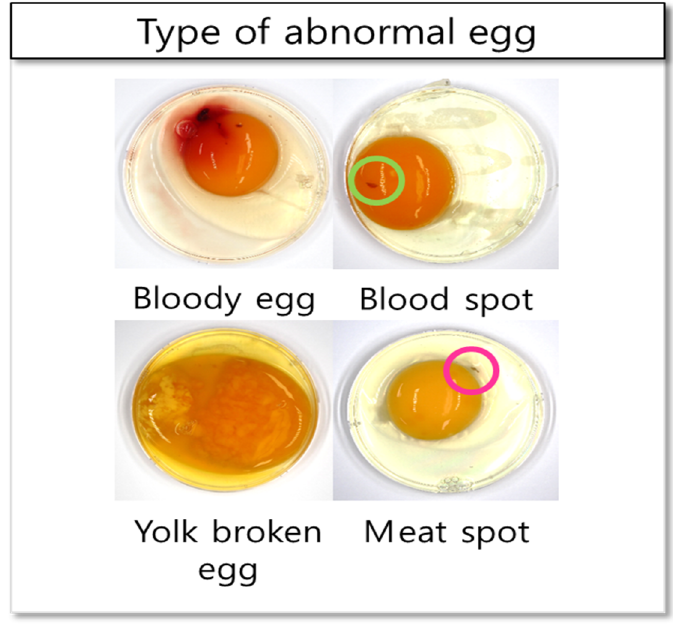
Figure 2. Sample images of yolk-destroyed eggs and bloody eggs .